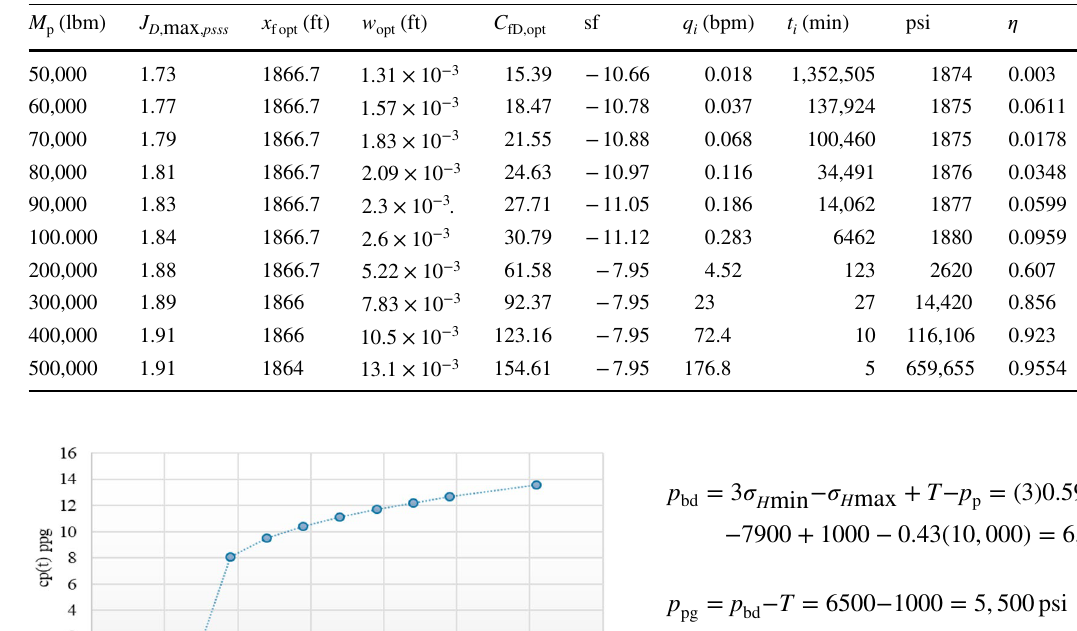
Table 5 Summary of results for k = 0.01